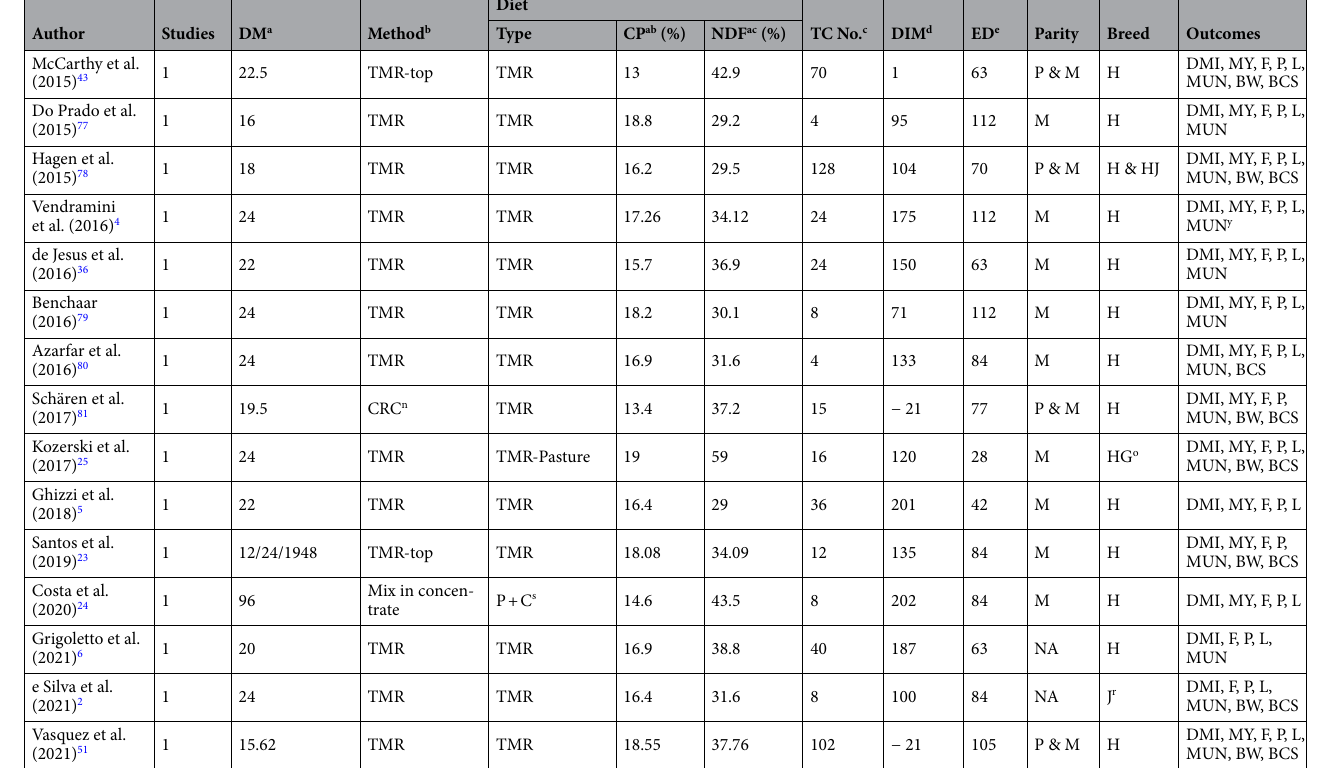
Table 1 . Summary of studies used in the meta-analysis on the effect of monensin supplementation in dairy cows. a Dosage of monensin (mg/kg DM). b Method of monensin supplementation. c Total cows’ number. d Days in milk at treatment start. e Experiment duration (d). f Total mixed rations. g Multiparous. h Holstein. i Holstein and Holstein × Jersey. j Primiparous. k Holstein–Friesian. l The "–" sign on the number indicates the days